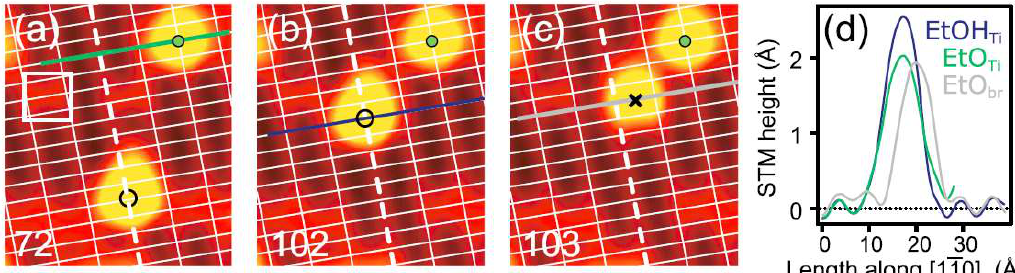
Figure 2. Consecutive STM images recording the diffusion and dissociation of a single EtOH molecule. ( a – c ) EtOH (indicated by a black open circle) diffuses along the Ti trough, gets trapped at O vac , leading to EtO br . Other symbols have the same indications as in Figure 1. ( d ) STM height profiles along the lines indicated in ( a – c ) (Reprinted figure with permission from [35] Copyright (2011) by the American Physical Society).